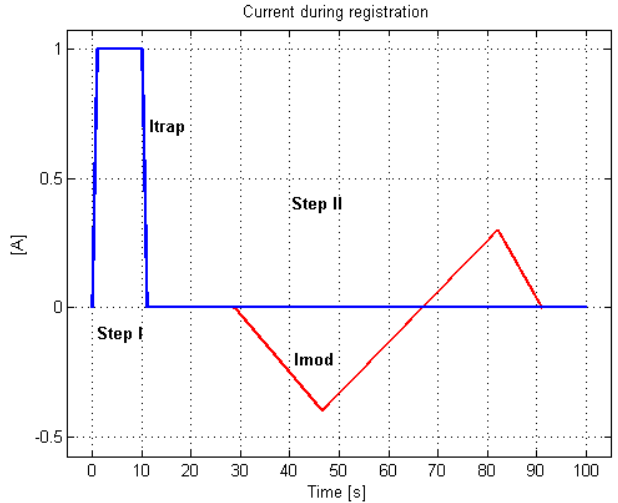
Figure 8. Trapezoidal pulse I trap and its modification in second step I mod .